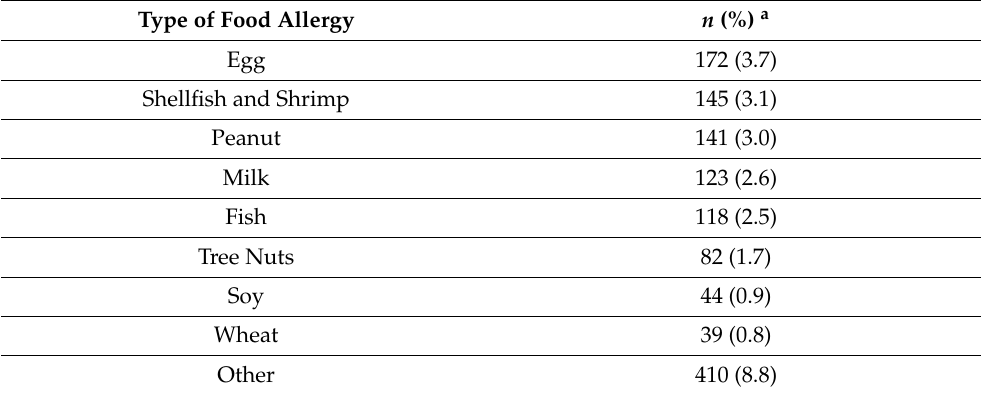
Table 3. Prevalence of self-reported specific food allergies in general adult population weighted sample ( n =